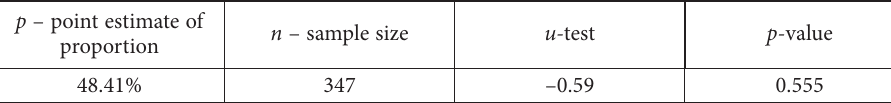
Table 3. Results of test about a population proportion p – point estimate of